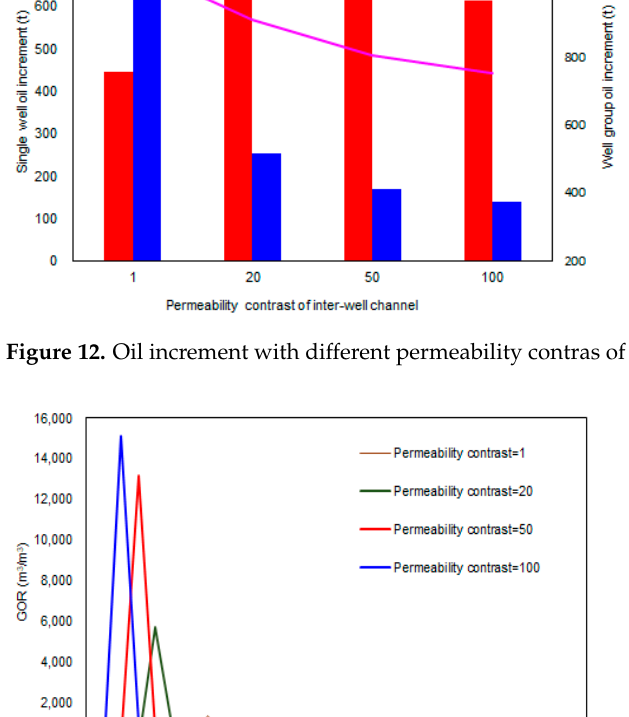
Figure 12. Oil increment with different permeability contras of inter-well channel.